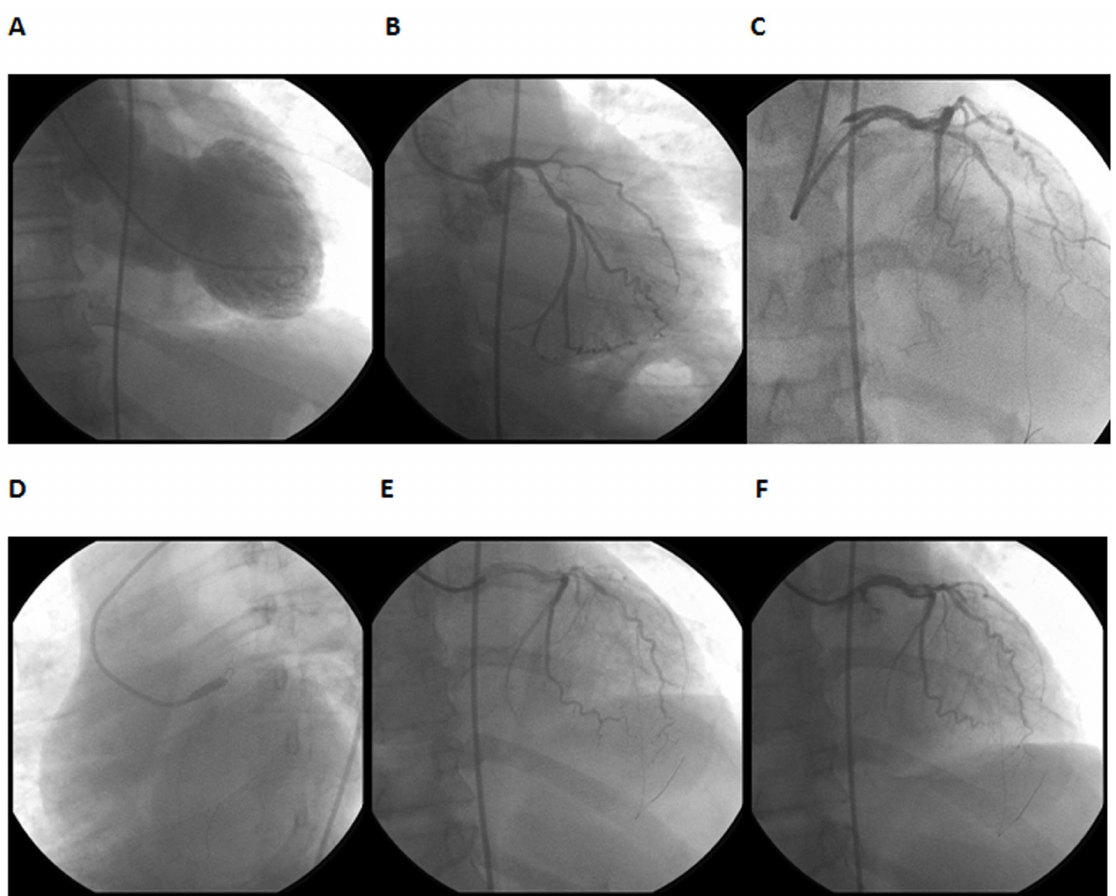
Fig. 1 - A sequência de fotos do CATE mostra: A- um ventrículo esquerdo dilatado e extensamente acinético em parede ântero- apical; B- a coronariografia antes da intervenção, com oclusão de artéria descendente anterior na origem; C- o momento da dissecção do tronco de coronária esquerda; D- o momento da insuflação do balão dilatador; E- mostra o stent no tronco chegando até a artéria circunflexa; F- coronariografia